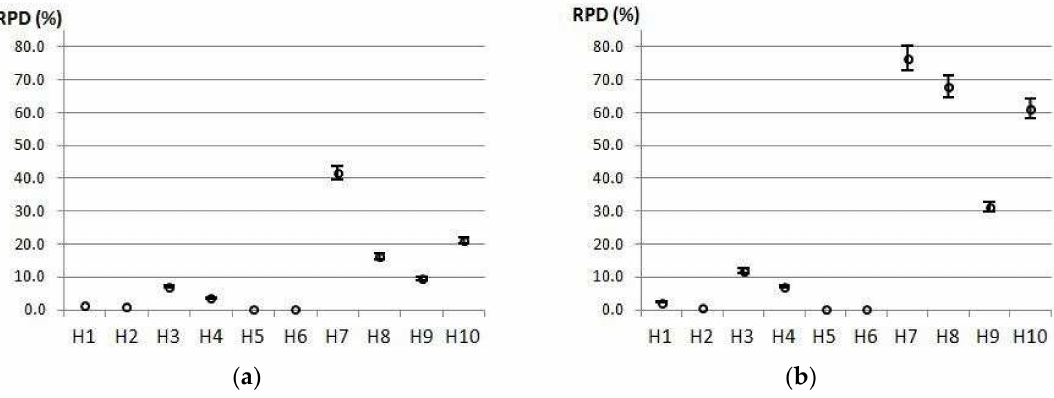
Figure 2. Comparison of performances of heuristics by group with 95% confidence interval of average RPD: ( a ) related to EM for Group 1; and ( b ) related to the best H1–H10 solution for Group